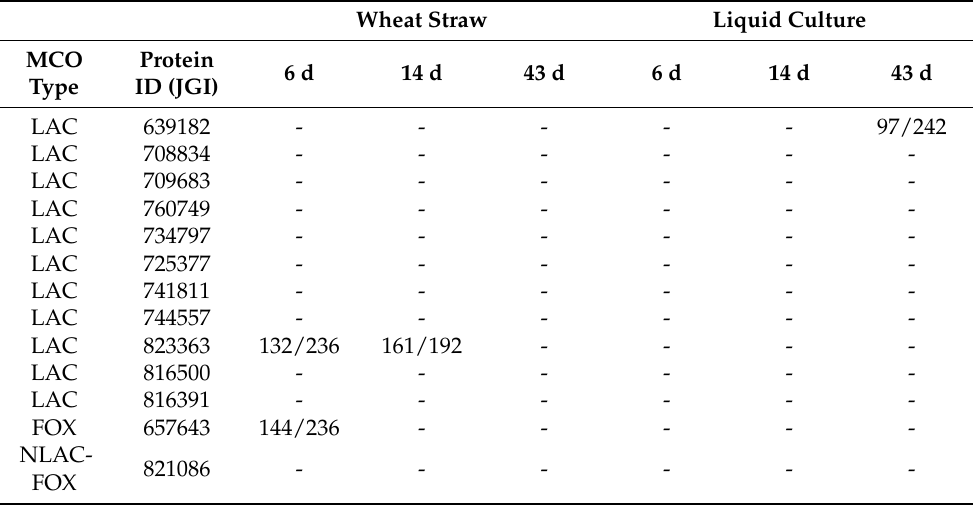
Table 1. Analysis of MCOs found in the secretomes of A. pediades grown under ligninolytic conditions (solid-state fermentation on wheat straw) and non-ligninolytic conditions (liquid culture in glucose- ammonium medium). Laccase (LAC), ferroxidase (FOX) and novel laccase-ferroxidase (NLAC-FOX). Out of the set of proteins identified in the fungal secretome after 6 d (236 proteins) or 14 d (192 proteins) of solid-state fermentation, laccase ID 823363 occupied the 132nd and 161st positions, respectively, in terms of PSM values. The majority of MCOs were not detected